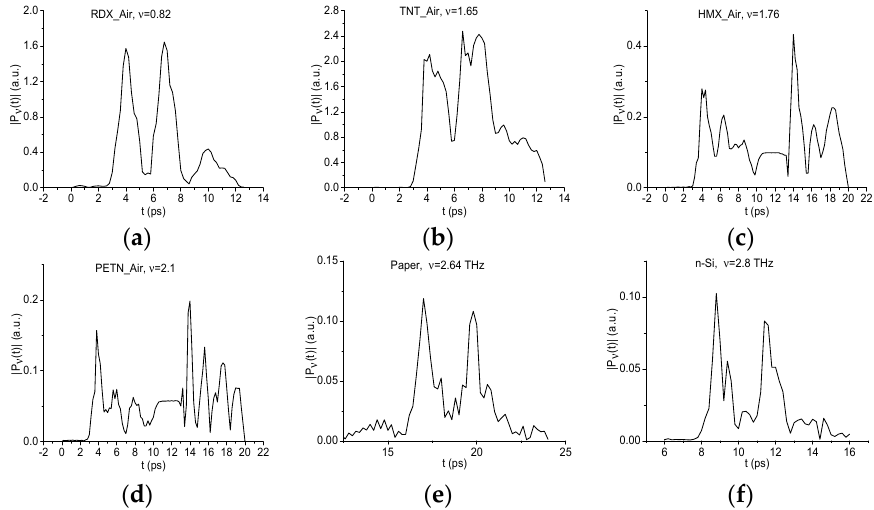
Figure 10. Spectral line dynamics at the frequencies ν = 0.82 THz (RDX_Air) ( a ), 1.65 THz (TNT_Air) ( b ), 1.76 THz (HMX_Air) ( c ), 2.1 THz (PETN_Air) ( d ), 2.64 THz (paper) ( e ), and 2.8 THz (n-Si) ( f ).